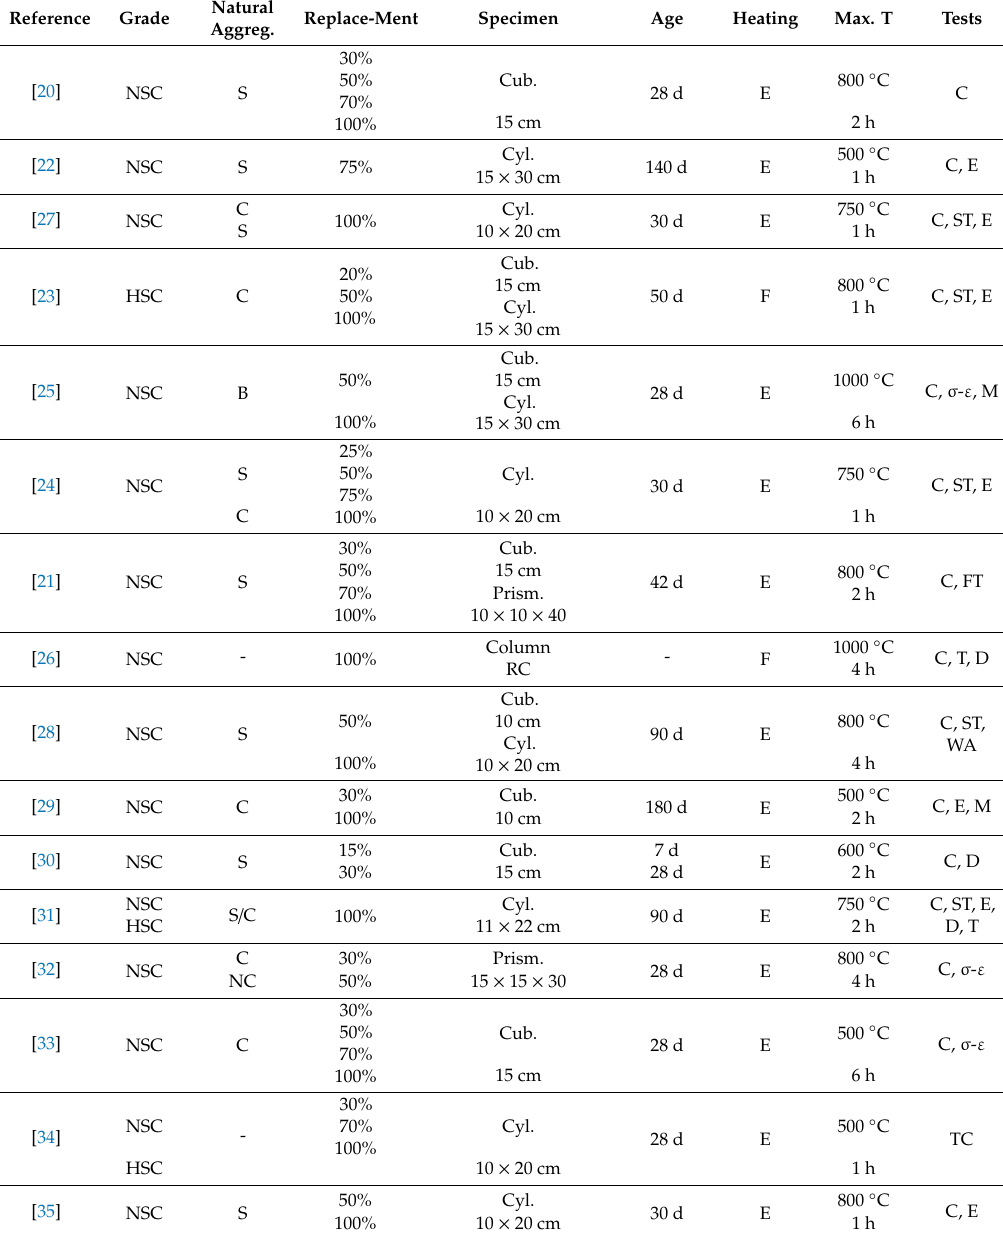
Table 1. Summary of the state-of-the-art concerning experiments on recycled aggregate concrete (RAC) at high temperatures